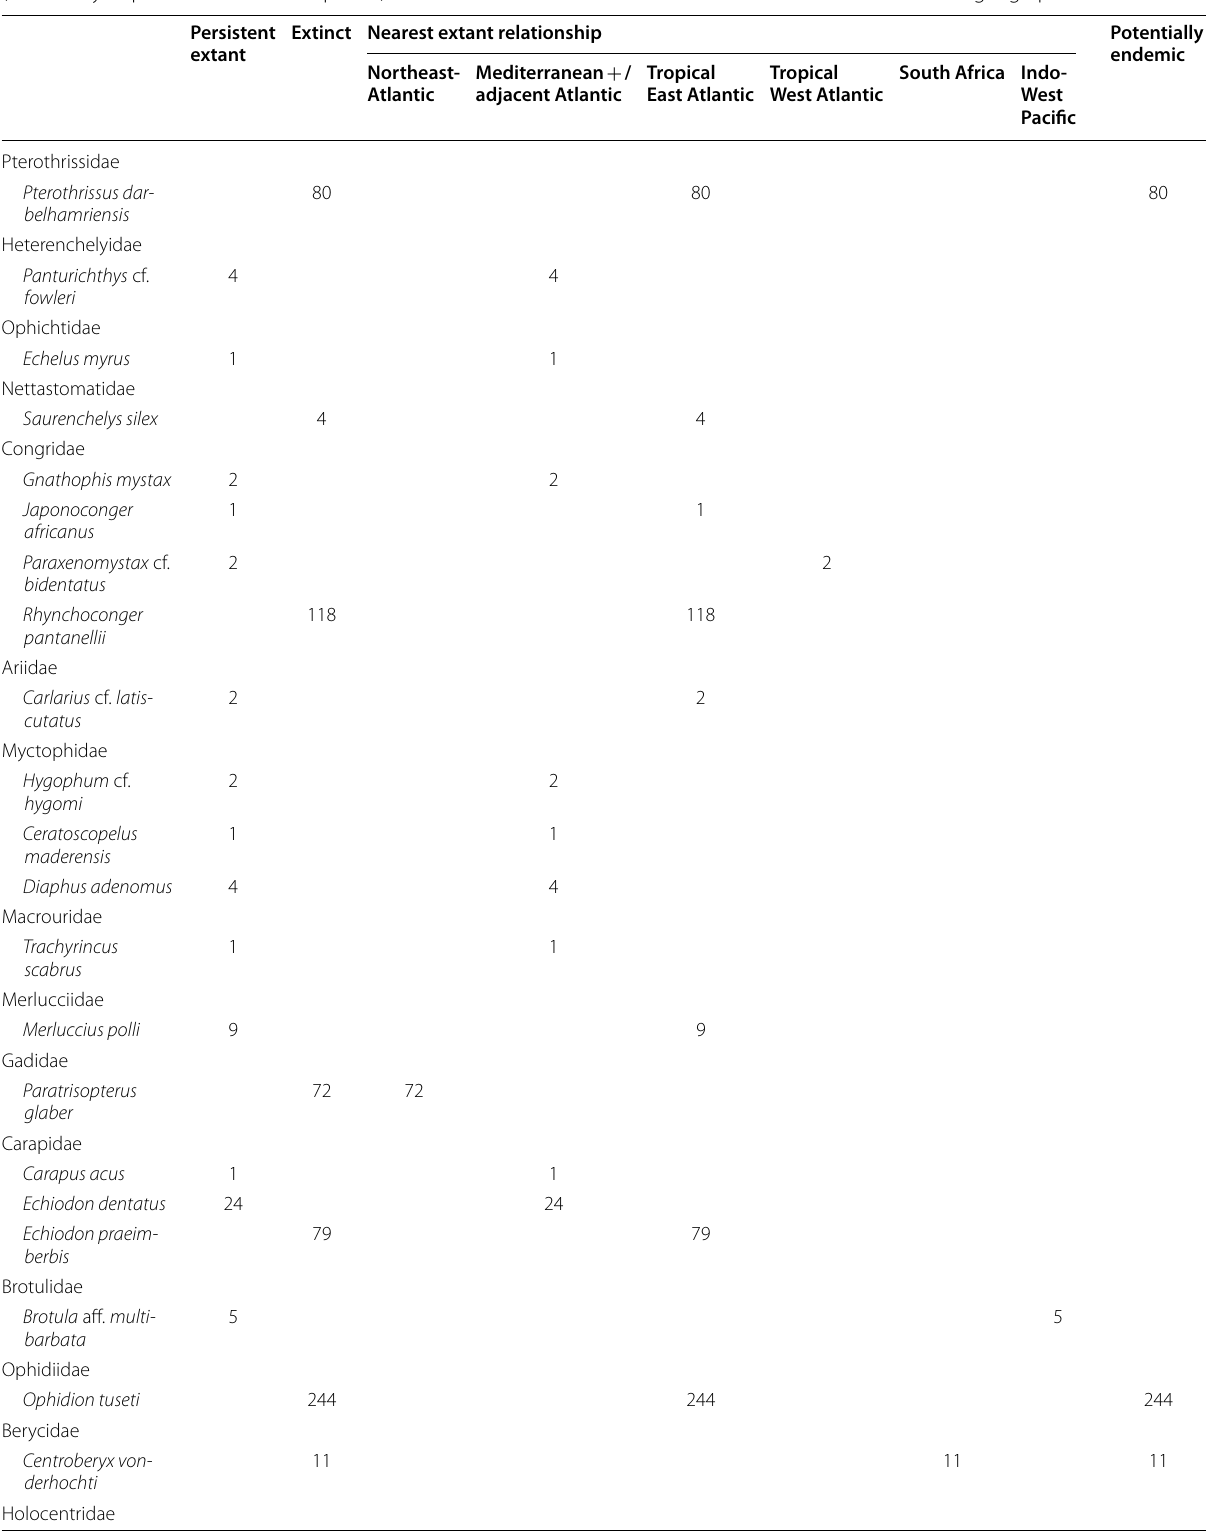
Table 3 Biogeographic relationships of extant and interpretable fossil species for. Asterisk indicates that non-interpretable species (extinct myctophid and macrourid species) are excluded from the calculations because of their uncertain biogeographic